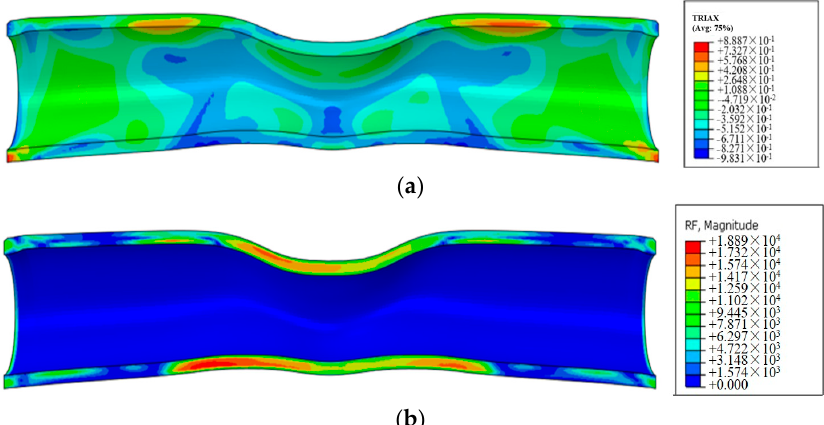
Figure 11. Simulation results when the elastic modulus of cement sheath is 9 Gpa: ( a ) stress triaxiality; ( b ) load.